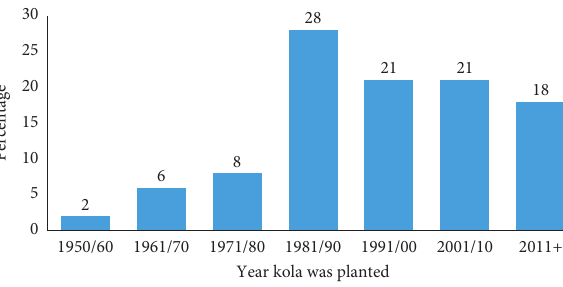
Figure 5: Year in which respondents planted kola trees. Table 5: Area under cultivation and production of kola